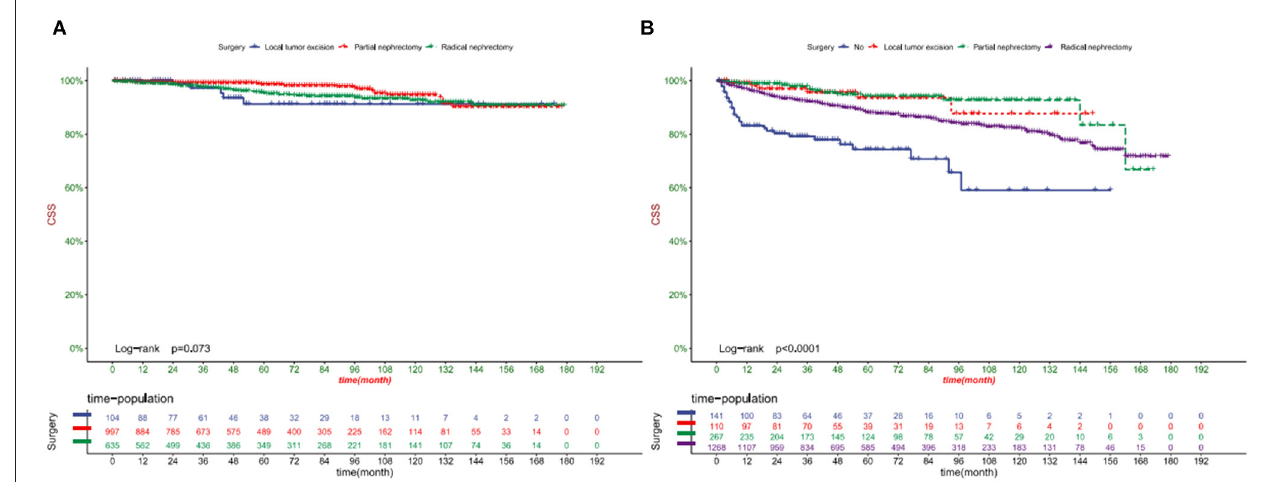
FIGURE 7 | Kaplan-Meier curves of patients with different surgical procedures in the low-risk group (A) and high-risk group (B)